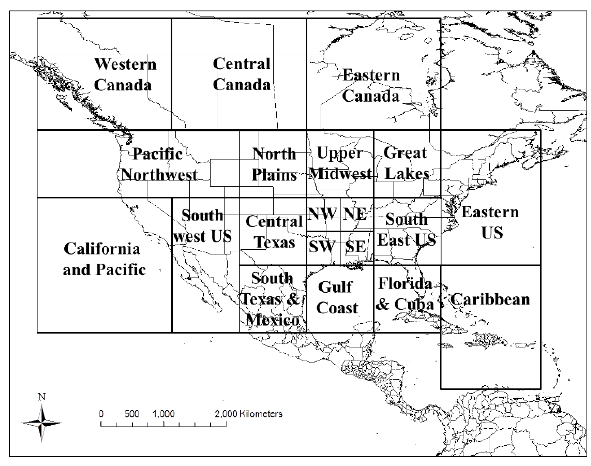
Figure 1. The predefined source regions for Little Rock, Arkansas. 2 Fig. 1. The predefined source regions for Little Rock,